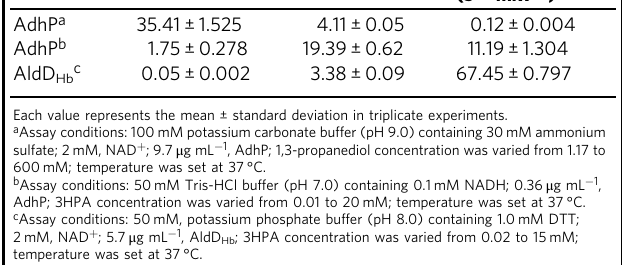
Table 1 Kinetic parameters of AdhP and AldD Hb .